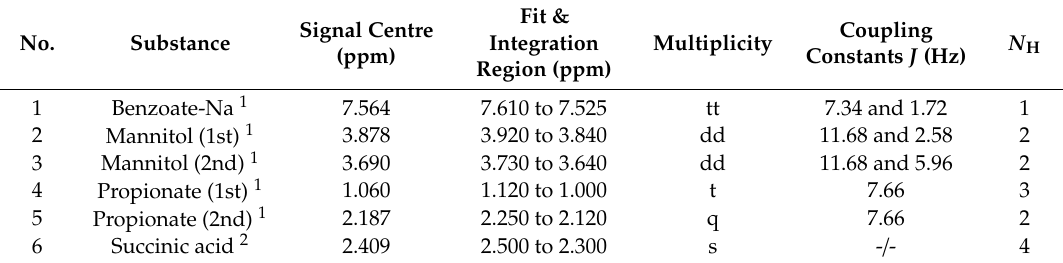
Table 2. Reference substances used in the QuantRef and the quality assurance